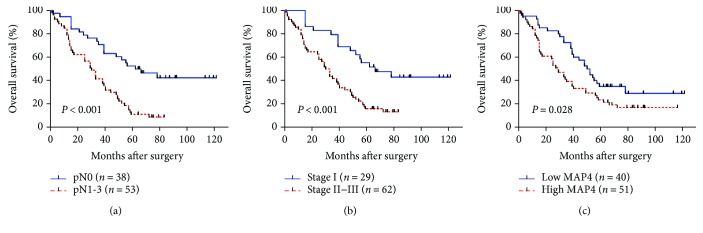
Clinicopathological parameter and MAP4 expression correlate with poor prognosis in human LADC patients. Kaplan-Meier overall survival curves for patients with N stage (a), TNM stage (b), and MAP4 expression levels (c) (log-rank test).